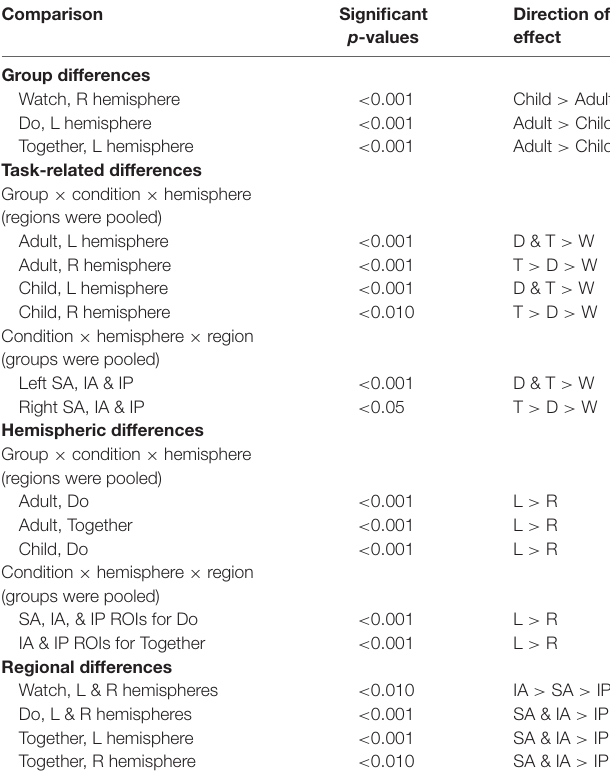
TABLE 4 | A listing of significant p -values and direction of the effect during post hoc t -tests.